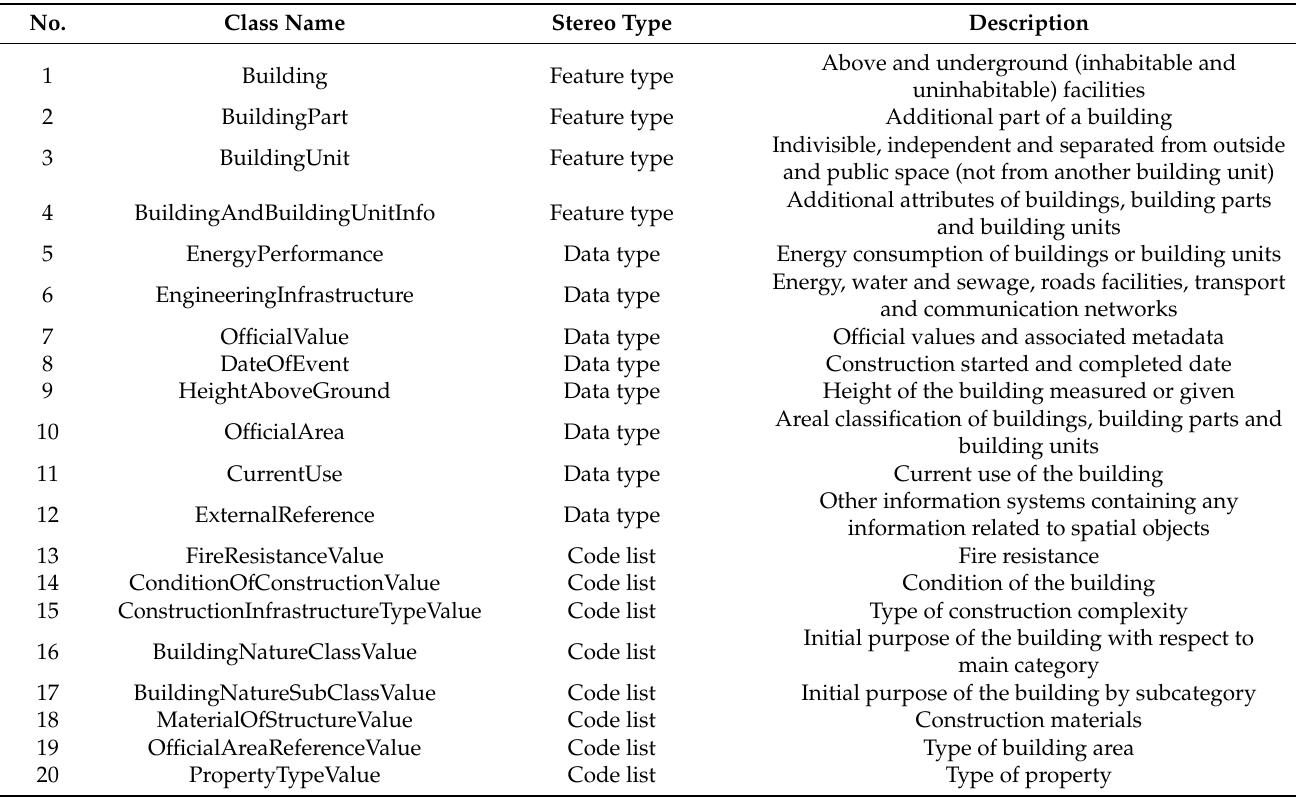
Table 2. Short description of UML class, datatype and code list of building construction